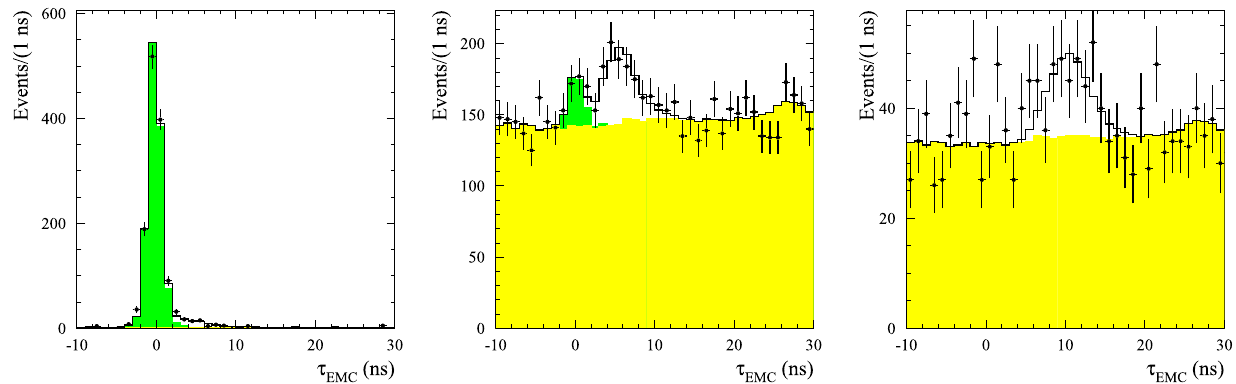
Fig. 10 The τ EMC distributions for data events with E b = 950, 951, 956MeVfromthe2019datasetselectedwithinvertedconditionsonthe parameters 5 ∧ 6 ∧ 7 ∧ 8 (left), 9 (middle), and 10 (right), where the con- dition numbers from Sect. 3 are used. The solid histogram is the result